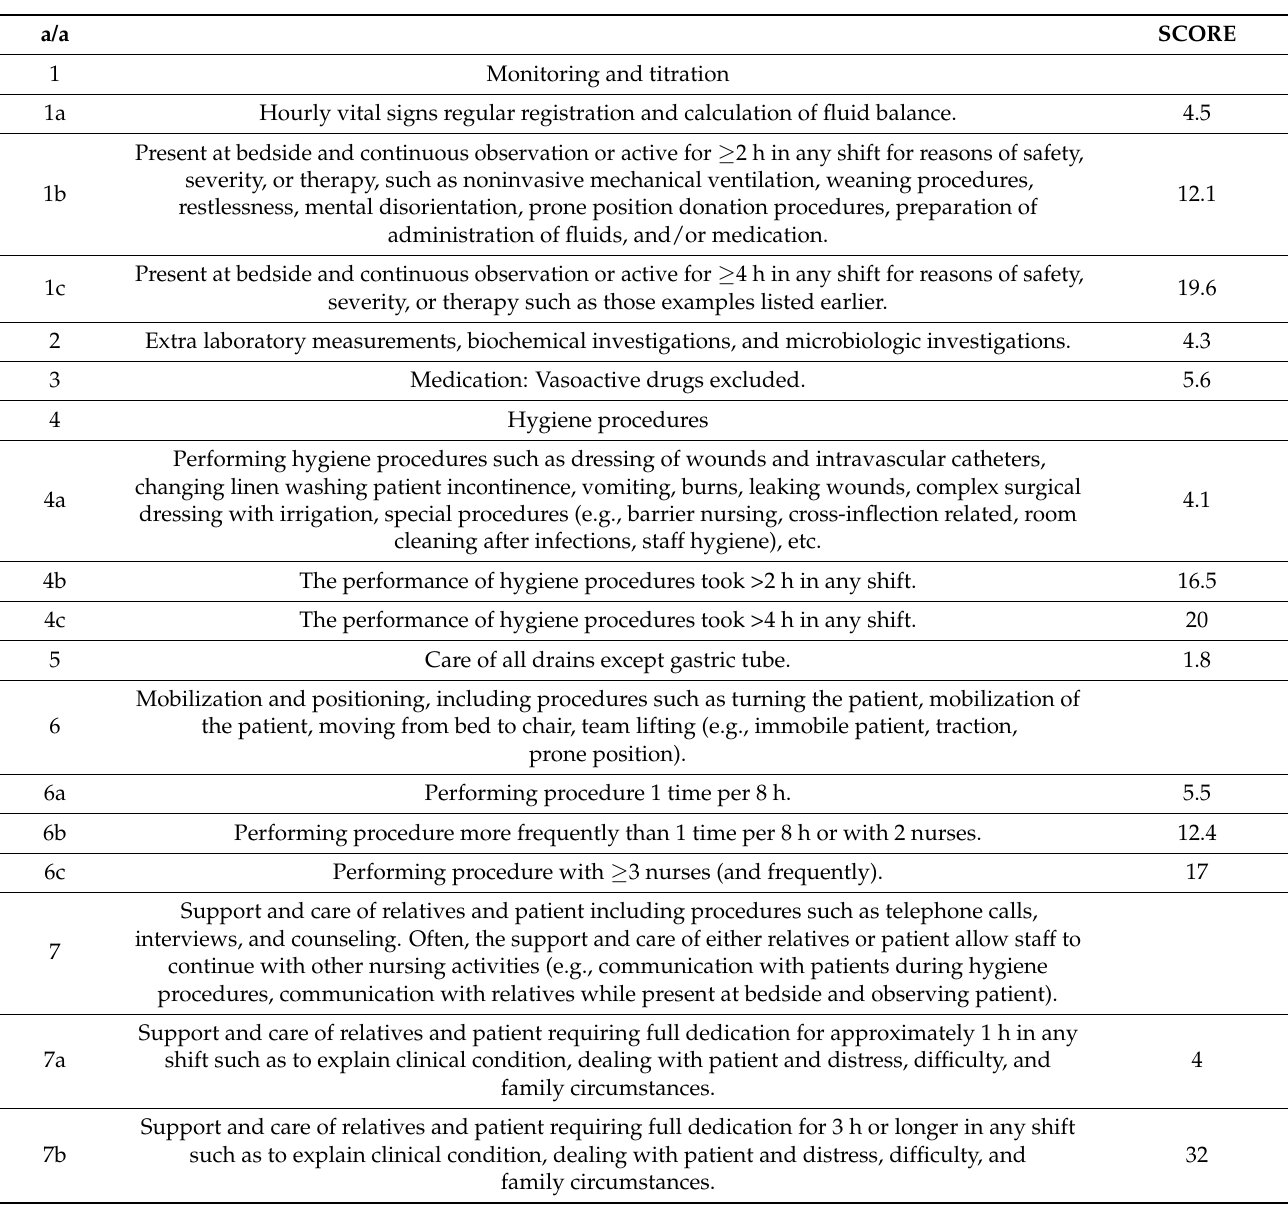
Table 1. Nursing activities score items and